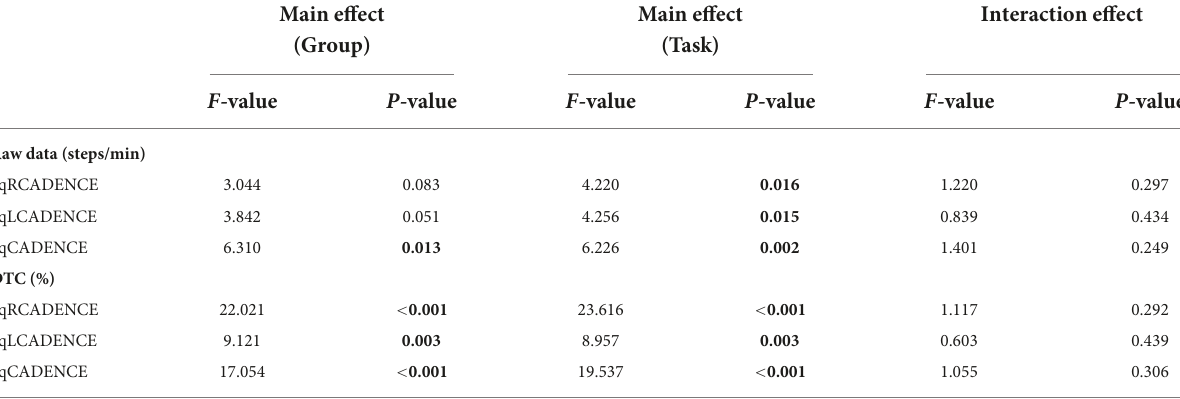
TABLE 5 Results of the repeated-measures analysis of variance on group and task for fqRCADENCE, fqLCADENCE, fqCADENCE.